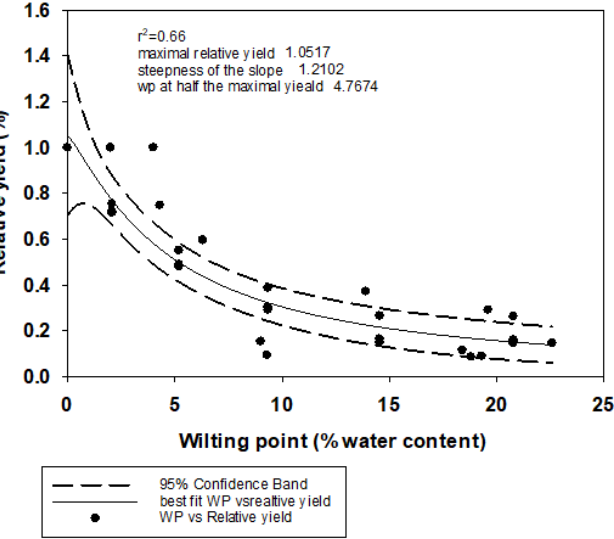
Figure 6. Observed data interpreted from experiments on golf courses for Bermuda grass and the 95% confidence band of the best fit.